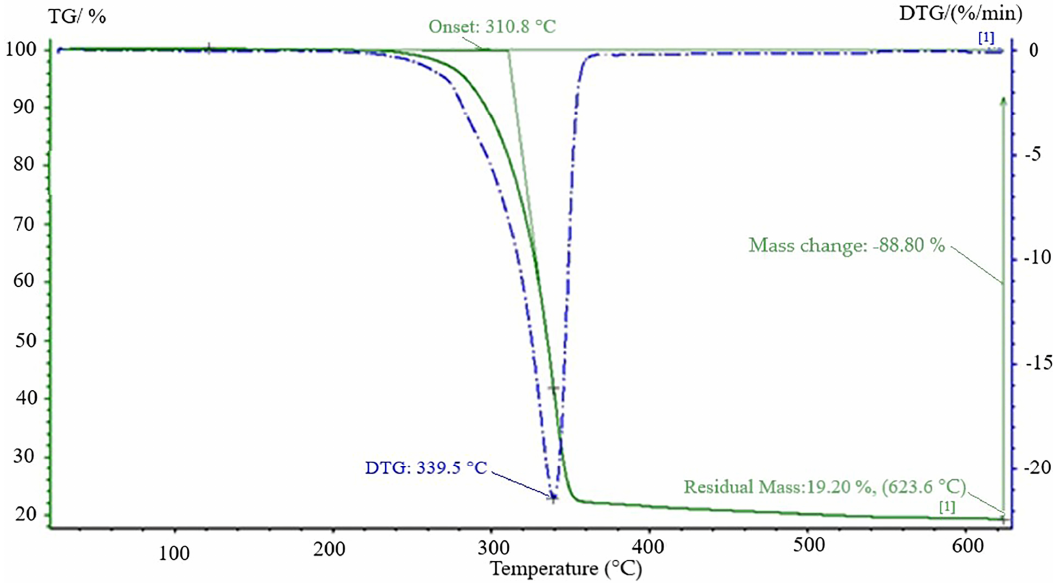
Figure 15. TGA curve of the Extrudr BDP Flax material.